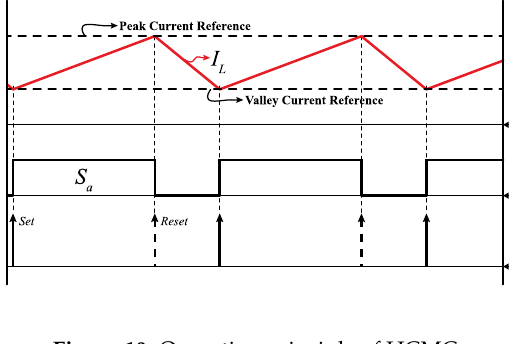
Figure 10. Operation principle of